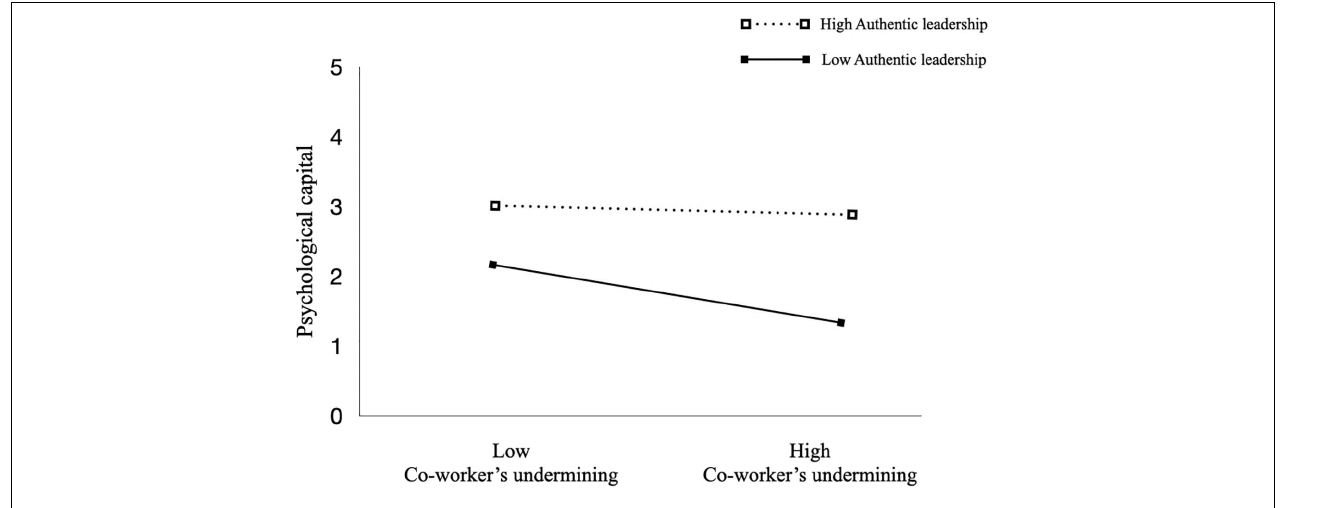
FIGURE 2 | Moderating effect of authentic